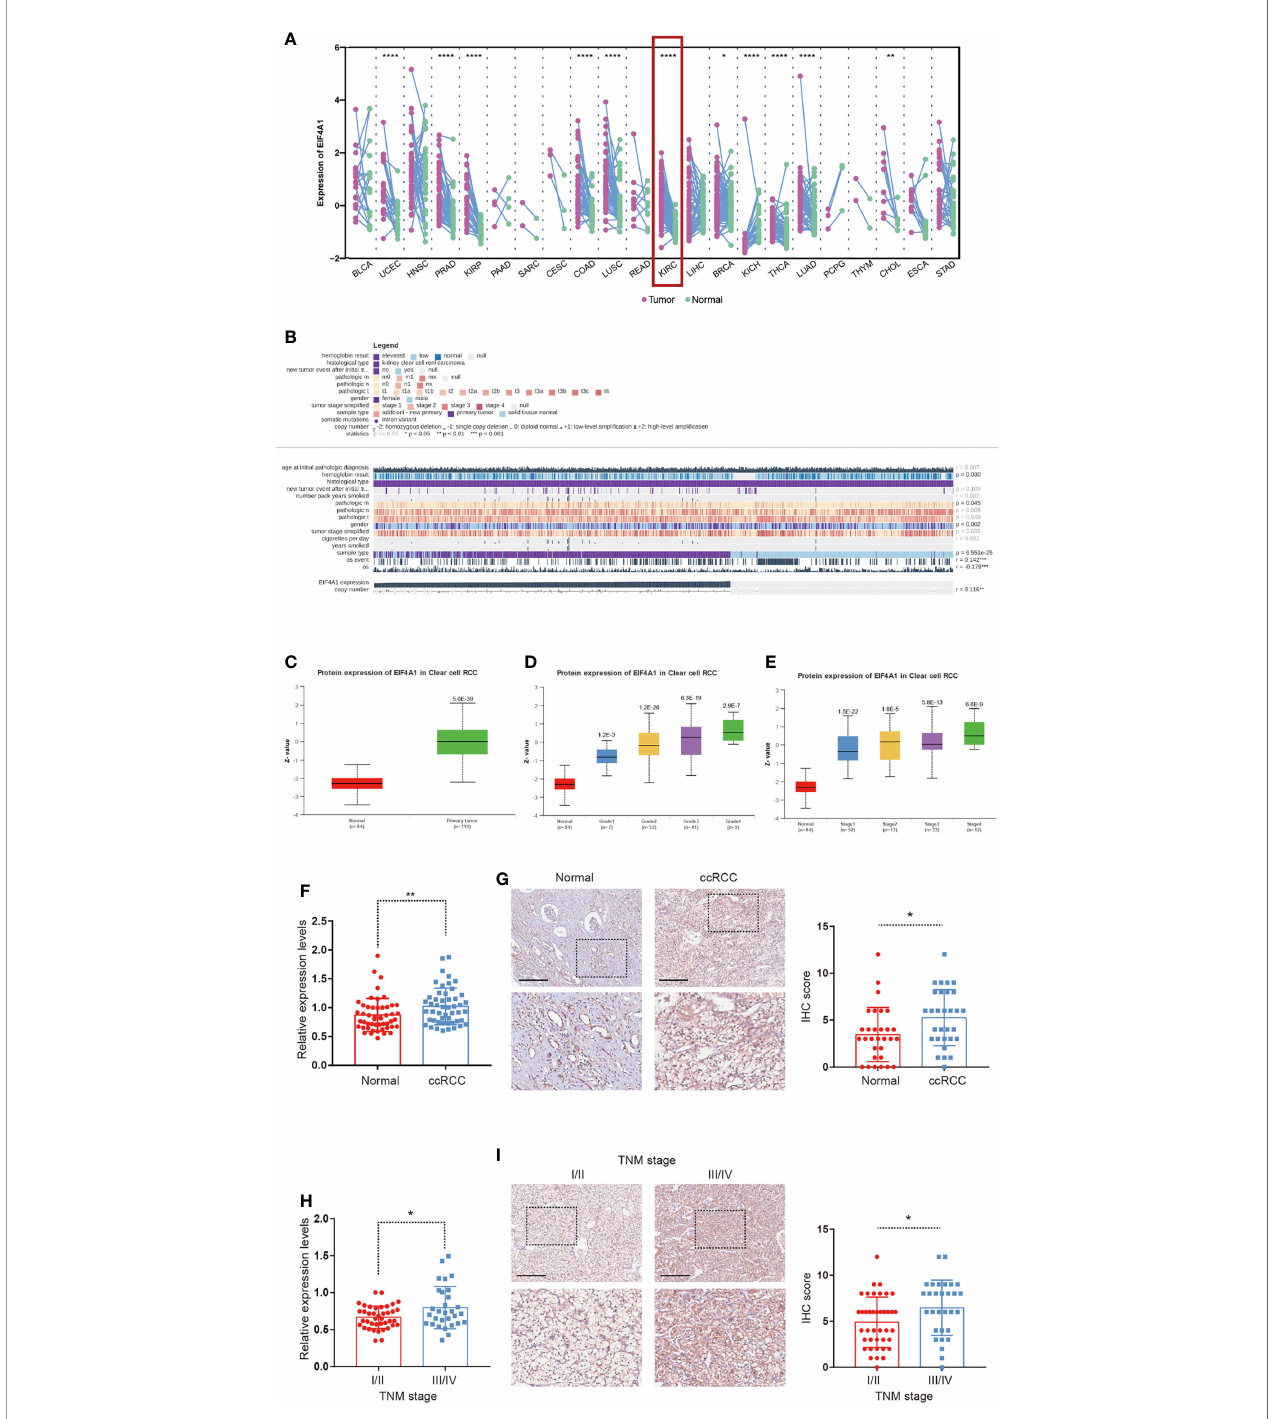
FIGURE 8 | Upregulation of EIF4A1 in ccRCC. (A) Differential expression of EIF4A1 in paired cancer and normal tissues of 22 cancer types from TCGA database. (B) The correlation between EIF4A1 expression and clinicopathologic features in ccRCC from MEXPRESS database. (C – E) Protein levels of EIF4A1 in ccRCC samples, classi fi ed by tumor grade, and histological pathological stage using the UALCAN database. (F, G) RT-qPCR-determined mRNA levels and IHC staining of EIF4A1 in ccRCC and paired adjacent normal renal tissues. (H, I) mRNA levels and IHC staining of EIF4A1 in ccRCC samples, classi fi ed by tumor stage. Scale bar: 250 m m. *P < 0.05; **P < 0.01; ****P <